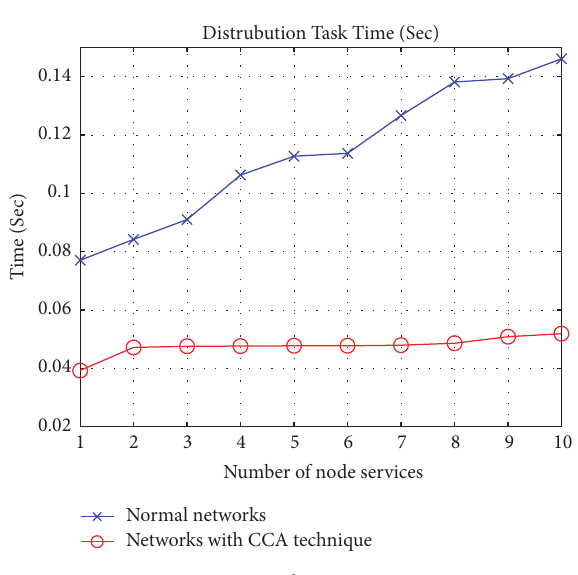
Figure 6: User applications are executed.